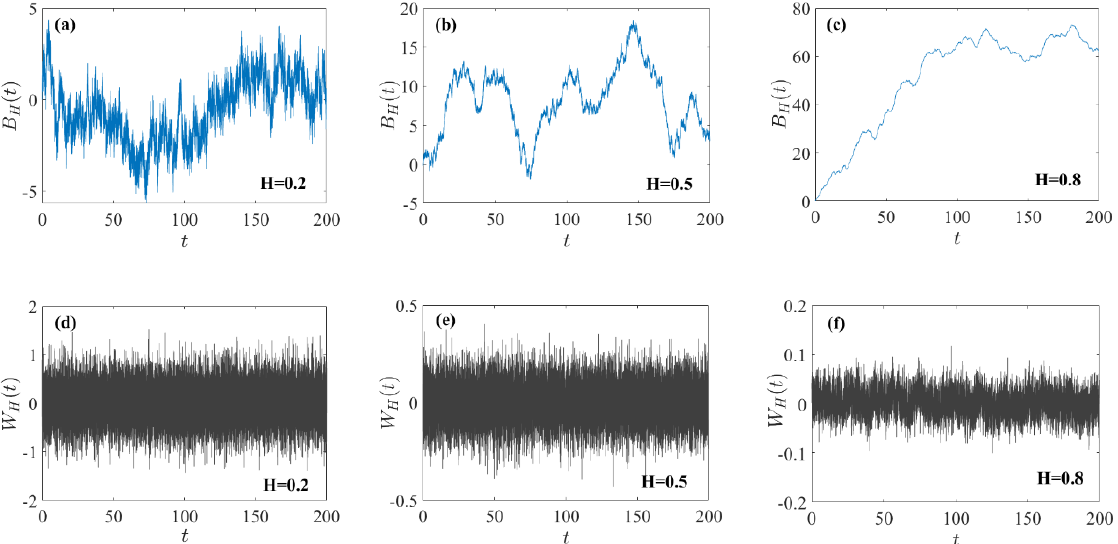
Figure 15. Realizations of FBM and FGN under three values of the Hurst index. ( a , d ) H = 0.2, ( b , e ) H = 0.5, ( c , f ) H = 0.8.